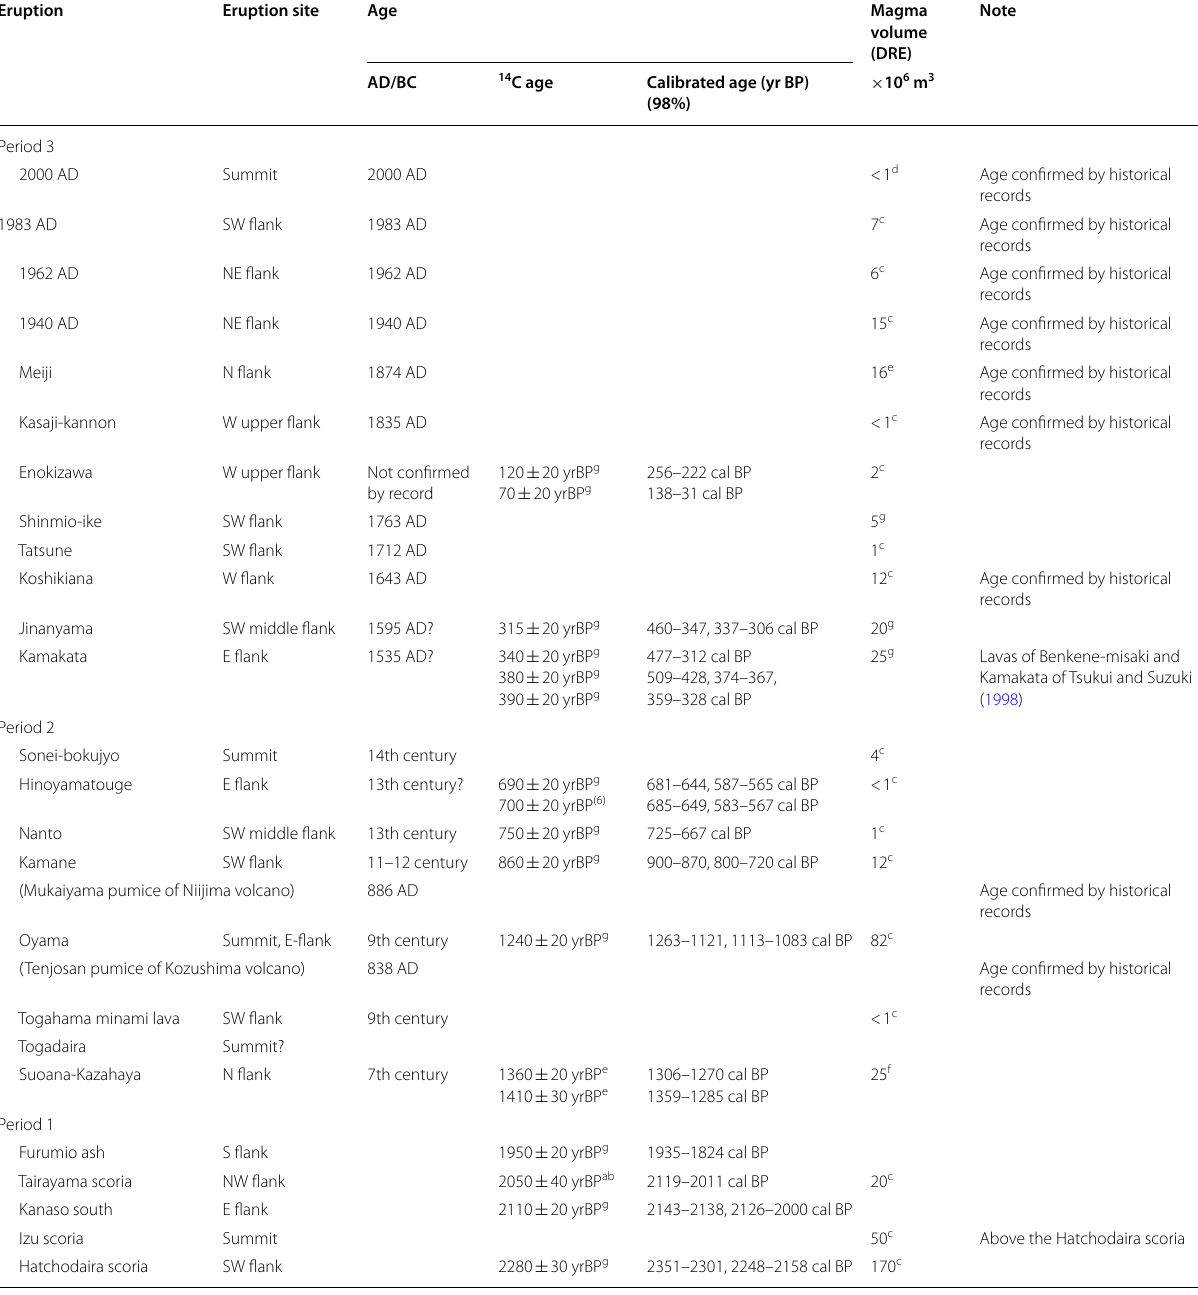
Table 1 Age of eruptions stratigraphycally younger than